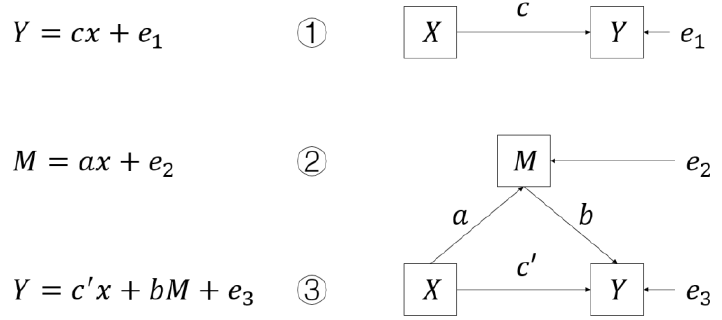
Figure 1. Illustration of the mediating effect model.